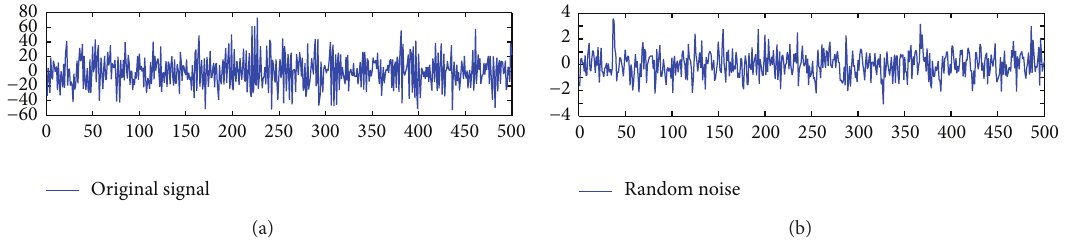
Figure 1: A real collected vibration signal from a roller bearing (a) and a created random white noise (b).